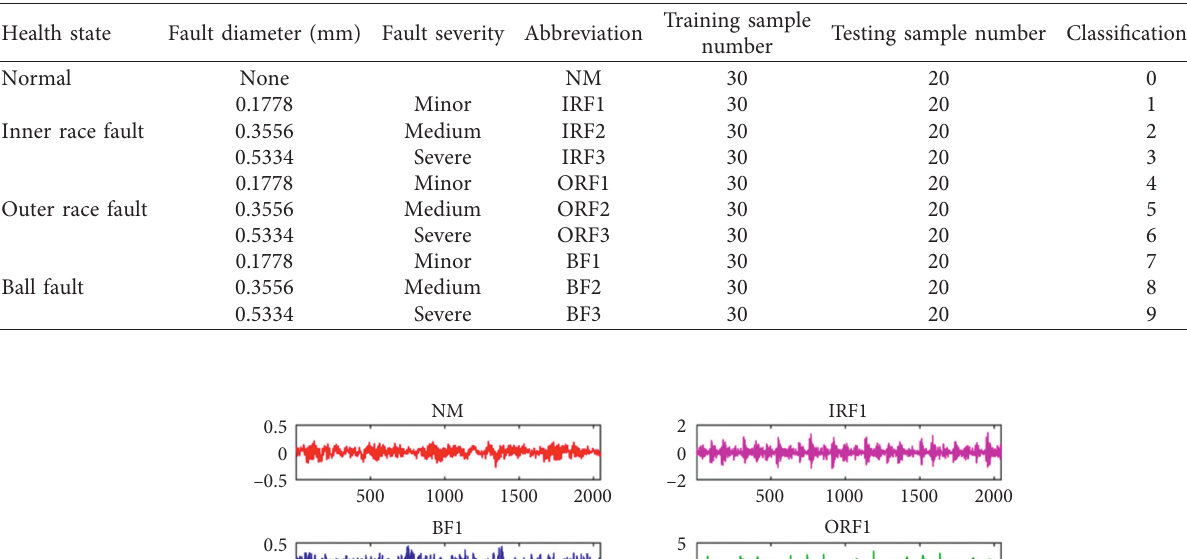
Table 1: The brief description of experimental data.